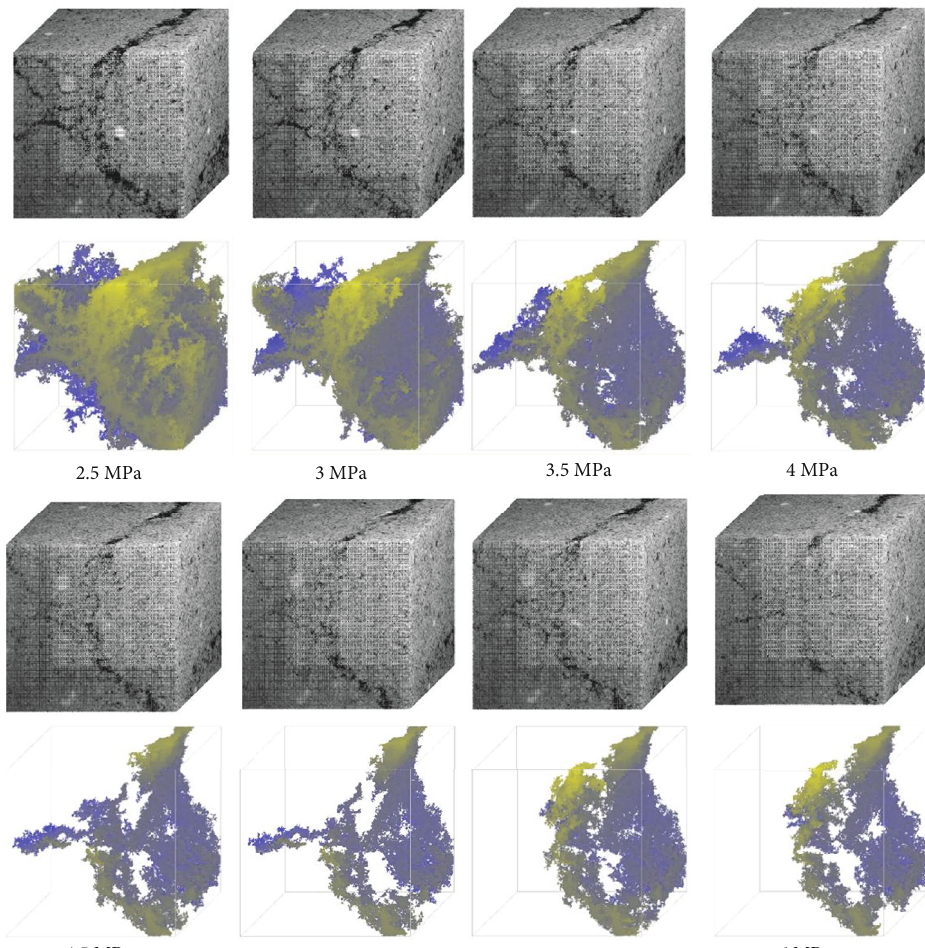
Figure 8: The 3D digital sample and the spatial distributions of the largest